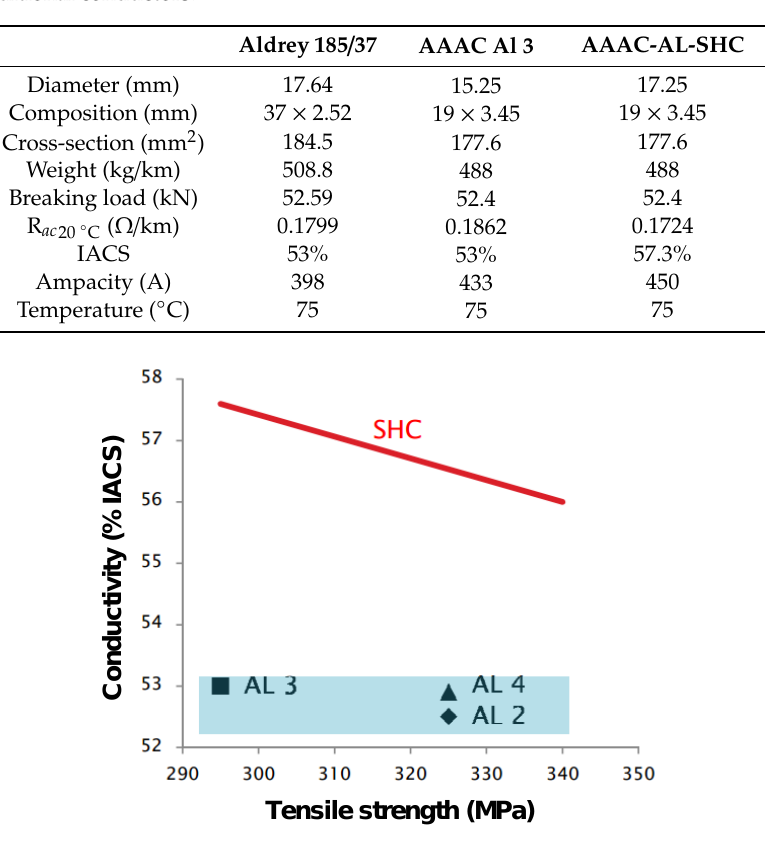
Figure 8. Comparison between traditional alloys (AL 2, AL 3, and AL 4 in azure area) and AAAC- SHC.